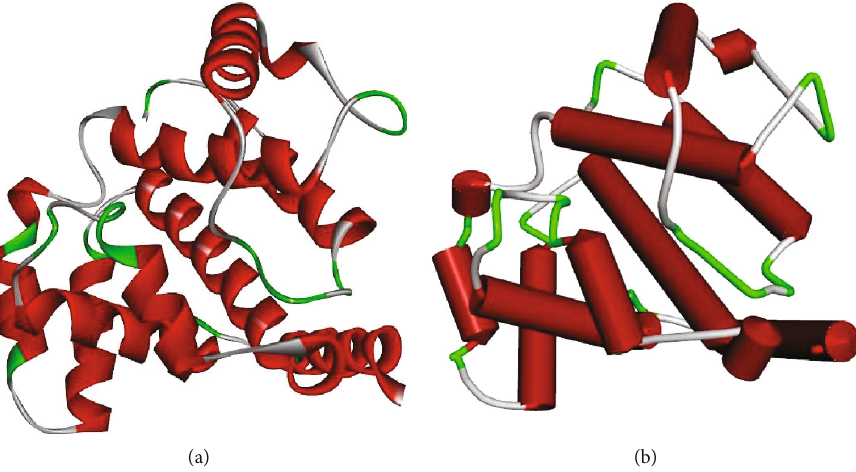
Figure 5: Modeled structure of ARAP3 (ArfGAP with RhoGAP domain, ankyrin repeat, and PH domain 3) represented in (a) ribbon and (b) schematic. Green regions represent beta sheets, white regions represent loops, and red regions represent alpha helices.